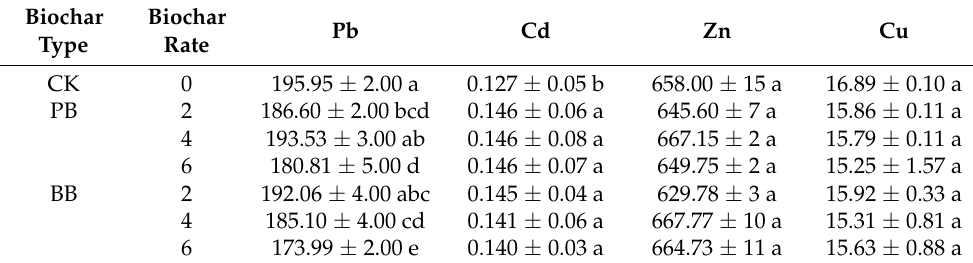
Table 7. Concentration of the residual fraction of soil heavy metals (mg kg − 1 ) determined with the BCR sequential extraction